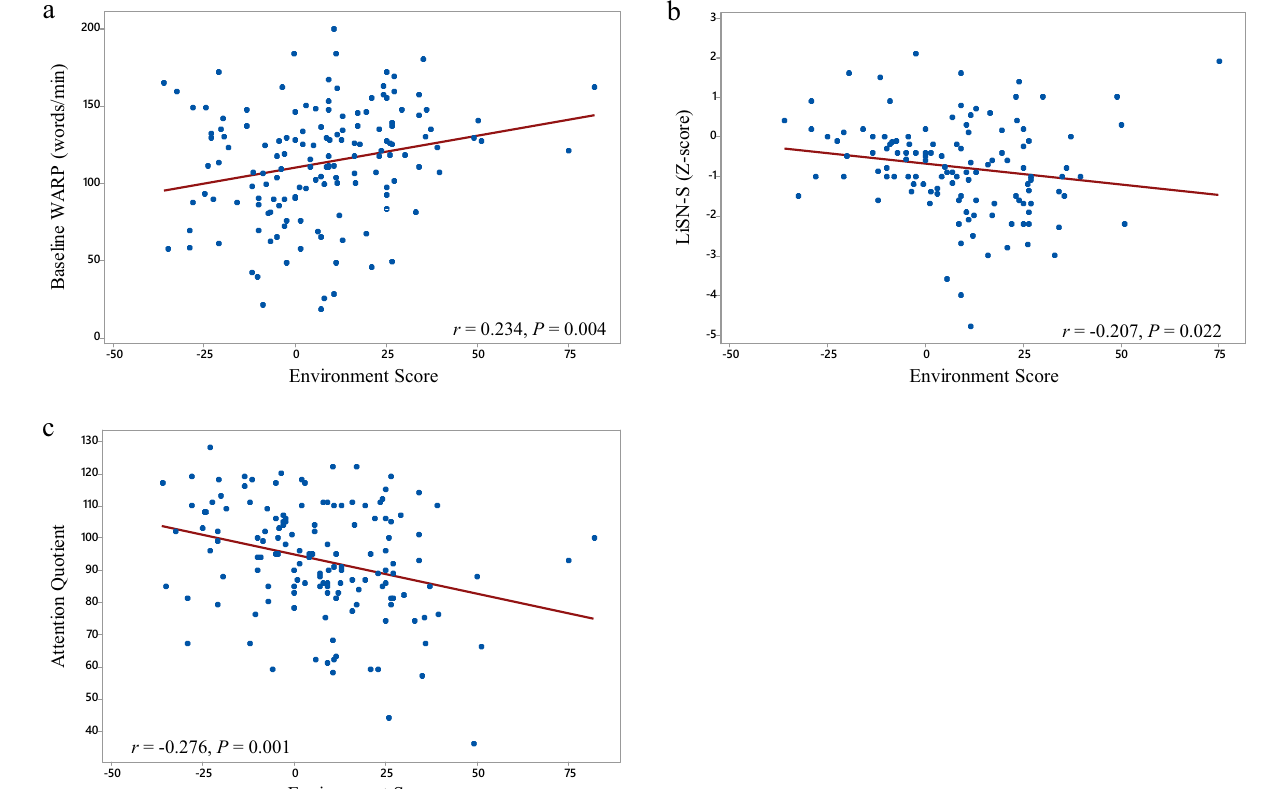
Fig. 4 Reading fl uency Environment Score (ES) for each student plotted as a function of participant characteristics. Panel ( a ) shows ES versus baseline reading fl uency, Panel ( b ) shows ES versus speech perception in noise and Panel ( c ) shows ES versus Attention.